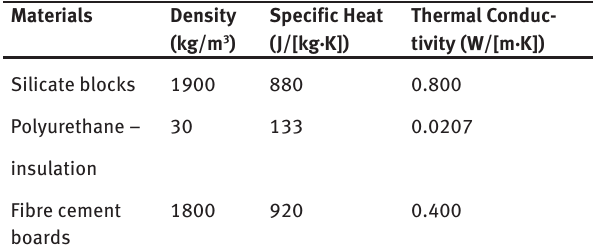
Table 1: Thermodynamic parameters of